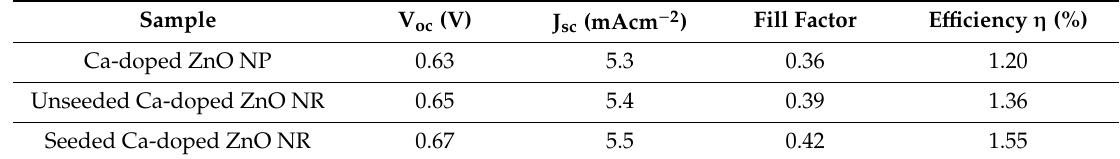
Table 4. Comparison of photovoltaic parameters for the prepared